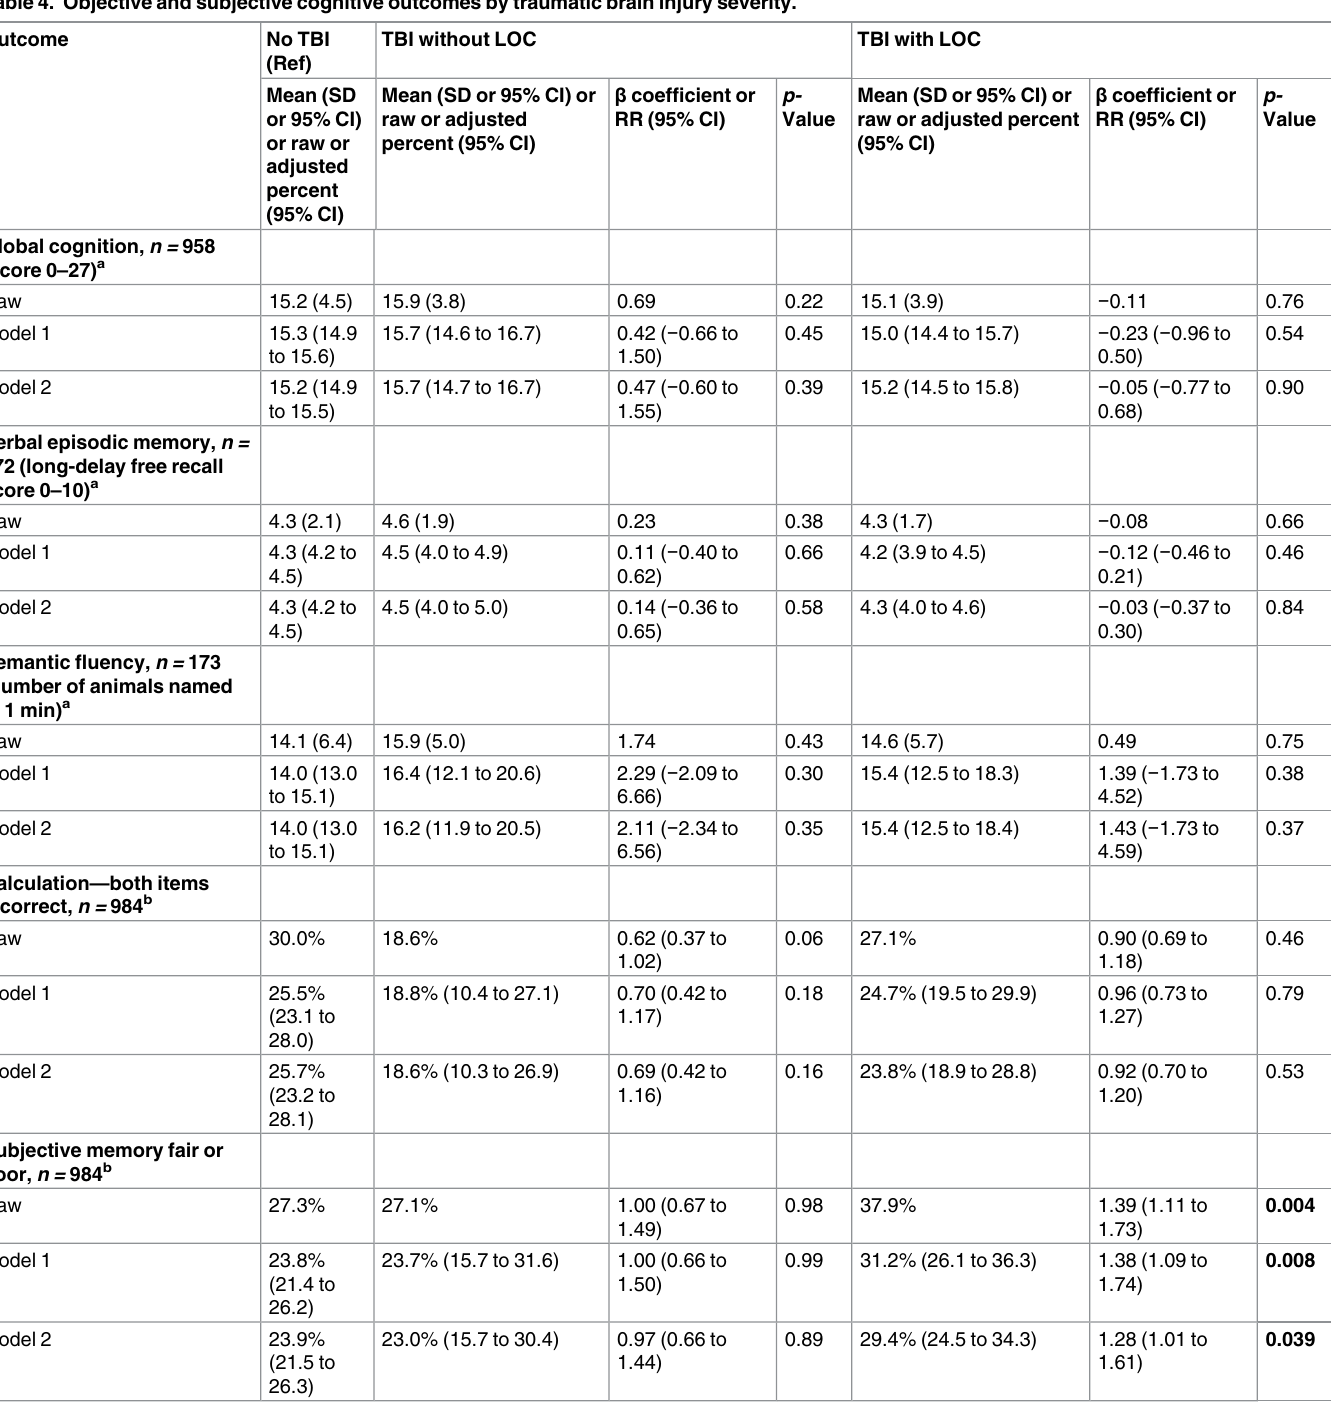
Table 4. Objective and subjective cognitive outcomes by traumatic brain injury